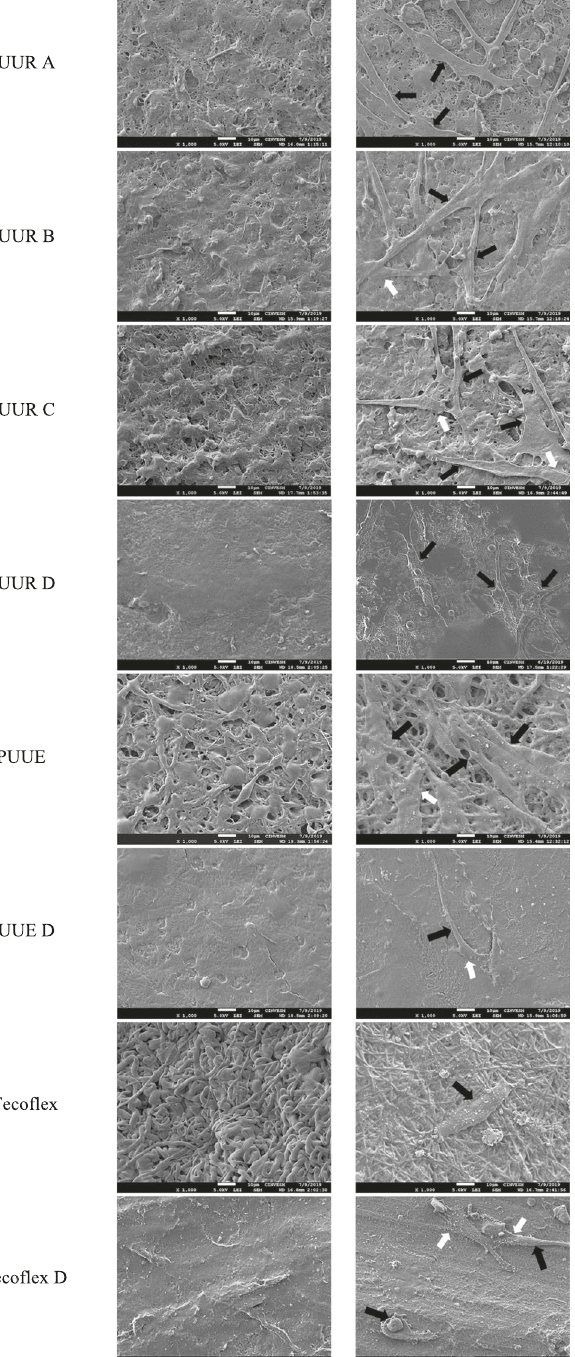
Fig. 8 SEM images of hFB cells after 24 h of incubation on electrospun and dense polyurethane membranes (PUUR A, PUUR B, PUUR C, and PUUE), and Teco fl ex. Black arrows show cells and white arrows indicate lamellipodia (1000x; 5